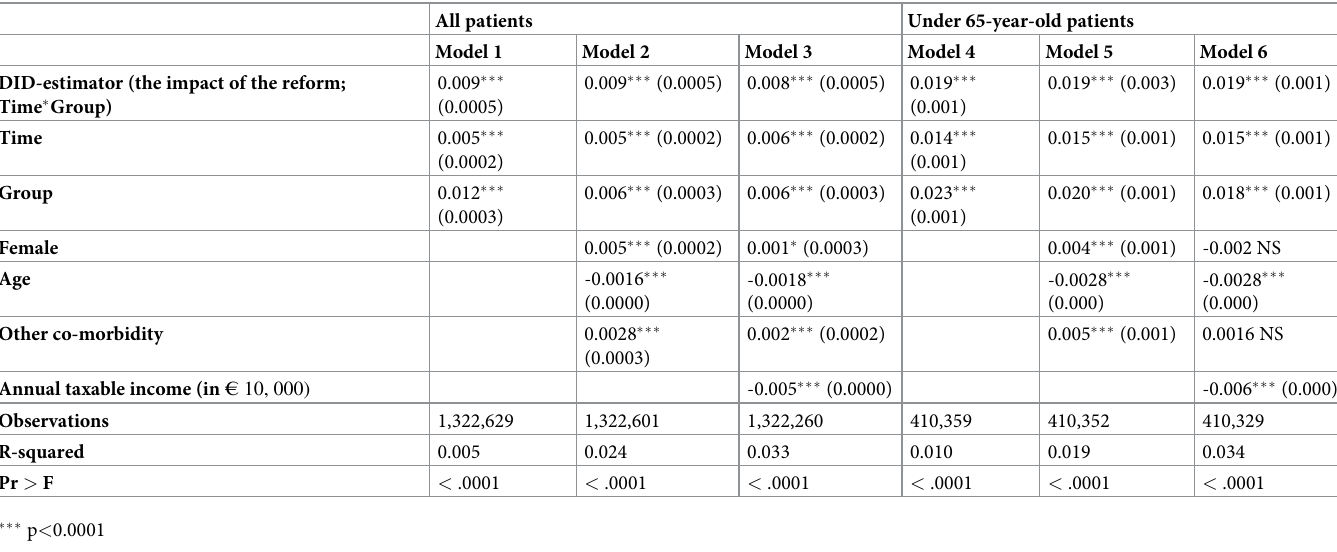
Table 2. Results of regression models for all patients and for patients under 65 years of